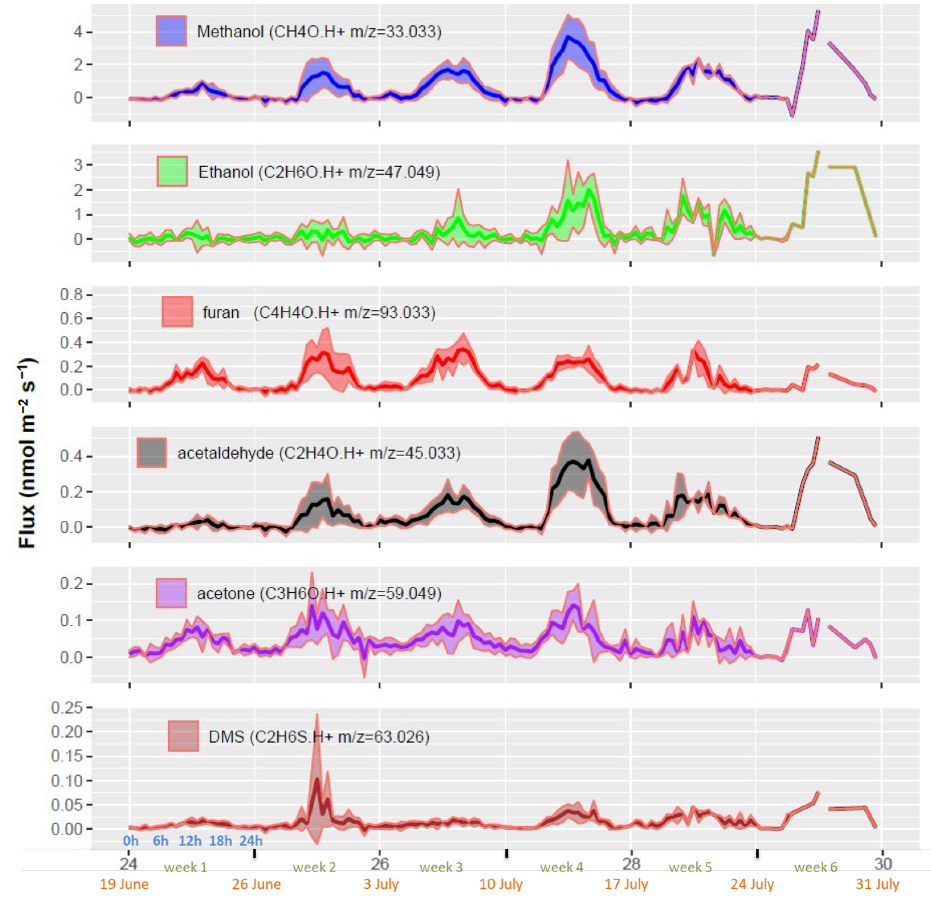
Figure 5. Whole ecosystem net fluxes of the six most emitted VOCs. Each week shows the diel cycle with its mean (line) and standard deviation (ribbons). The x axis denotes the week number in the year (black), the week number in the experiment (green), the starting date of the week (orange) and the hour of day (blue). Note that no standard deviations are shown for week 6 because only 1d of measurement was